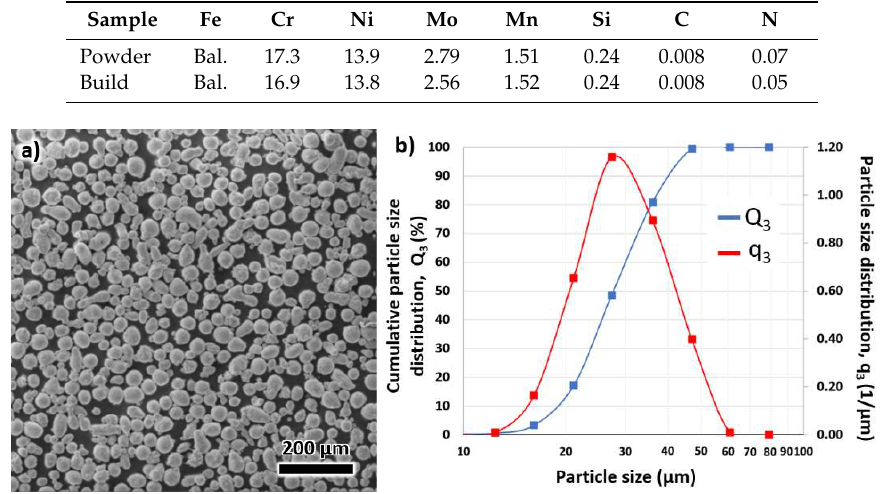
Table 1. Chemical composition (wt%) of the 316L stainless steel powders.